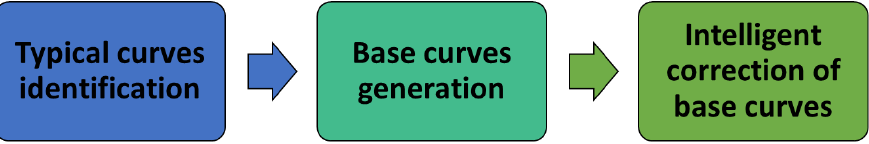
Figure 1. The proposed methodology to predict the energy demand in each city.